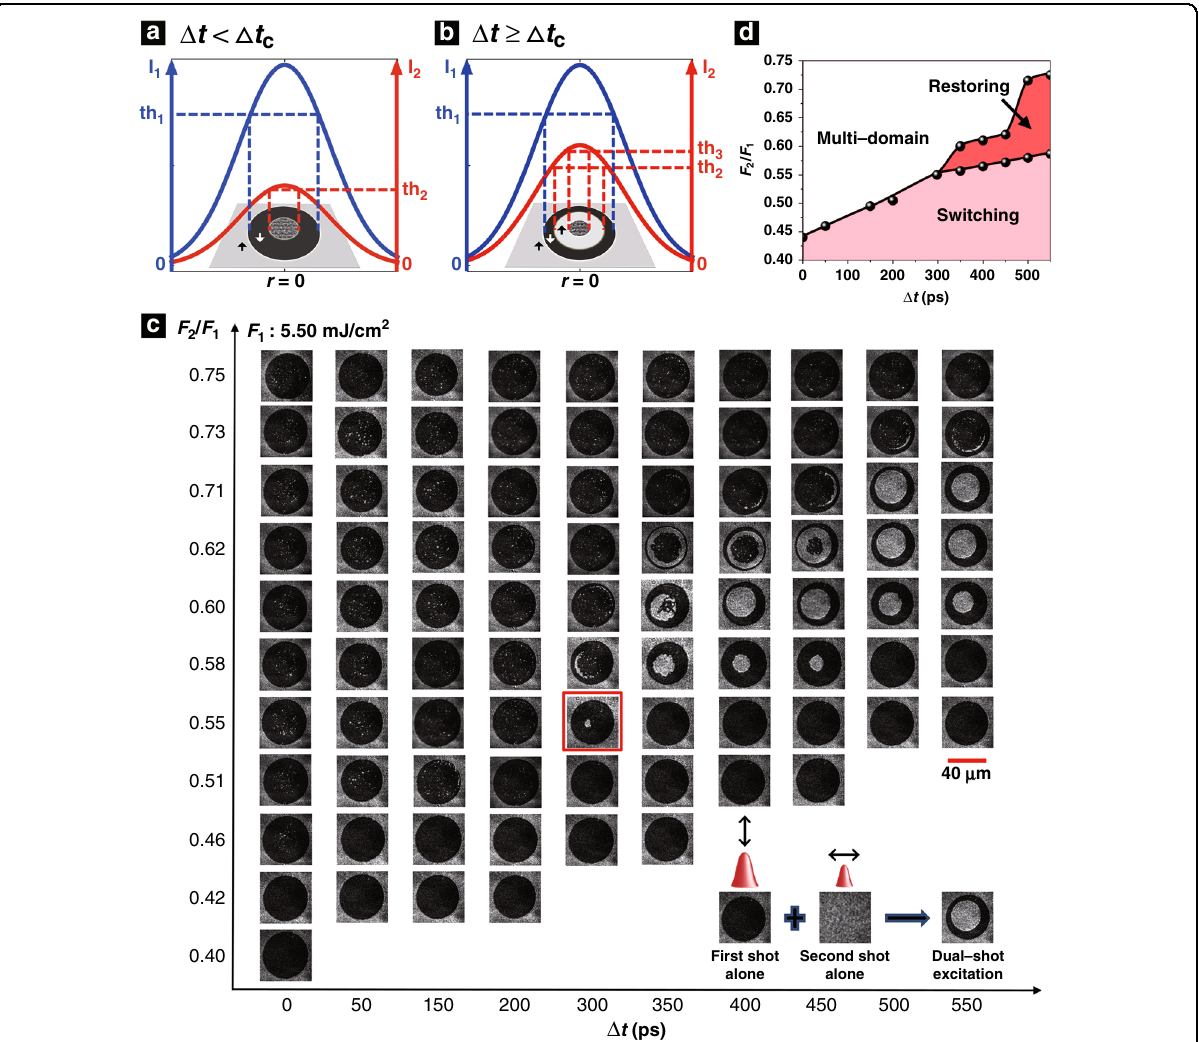
Fig. 2 The fi nal magnetization states of Gd 27 Fe 63.87 Co 9.13 under dual-shot excitation. a , b Sketches of the fi nal magnetization states of Gd 27 Fe 63.87 Co 9.13 under dual-shot excitation when Δ t < Δ t c ( a ) and when Δ t ≥ Δ t c ( b ). c The fi nal state distributions of Gd 27 Fe 63.87 Co 9.13 under dual- shot excitation versus Δ t and the pulse fl uence ratio ( F 2 / F 1 ) between the two pulses. The red frame indicates the onset of rewriting a magnetic bit by dual-shot excitation with minimal pulse-to-pulse separation. The scale bar is 40 μ m. d The corresponding phase